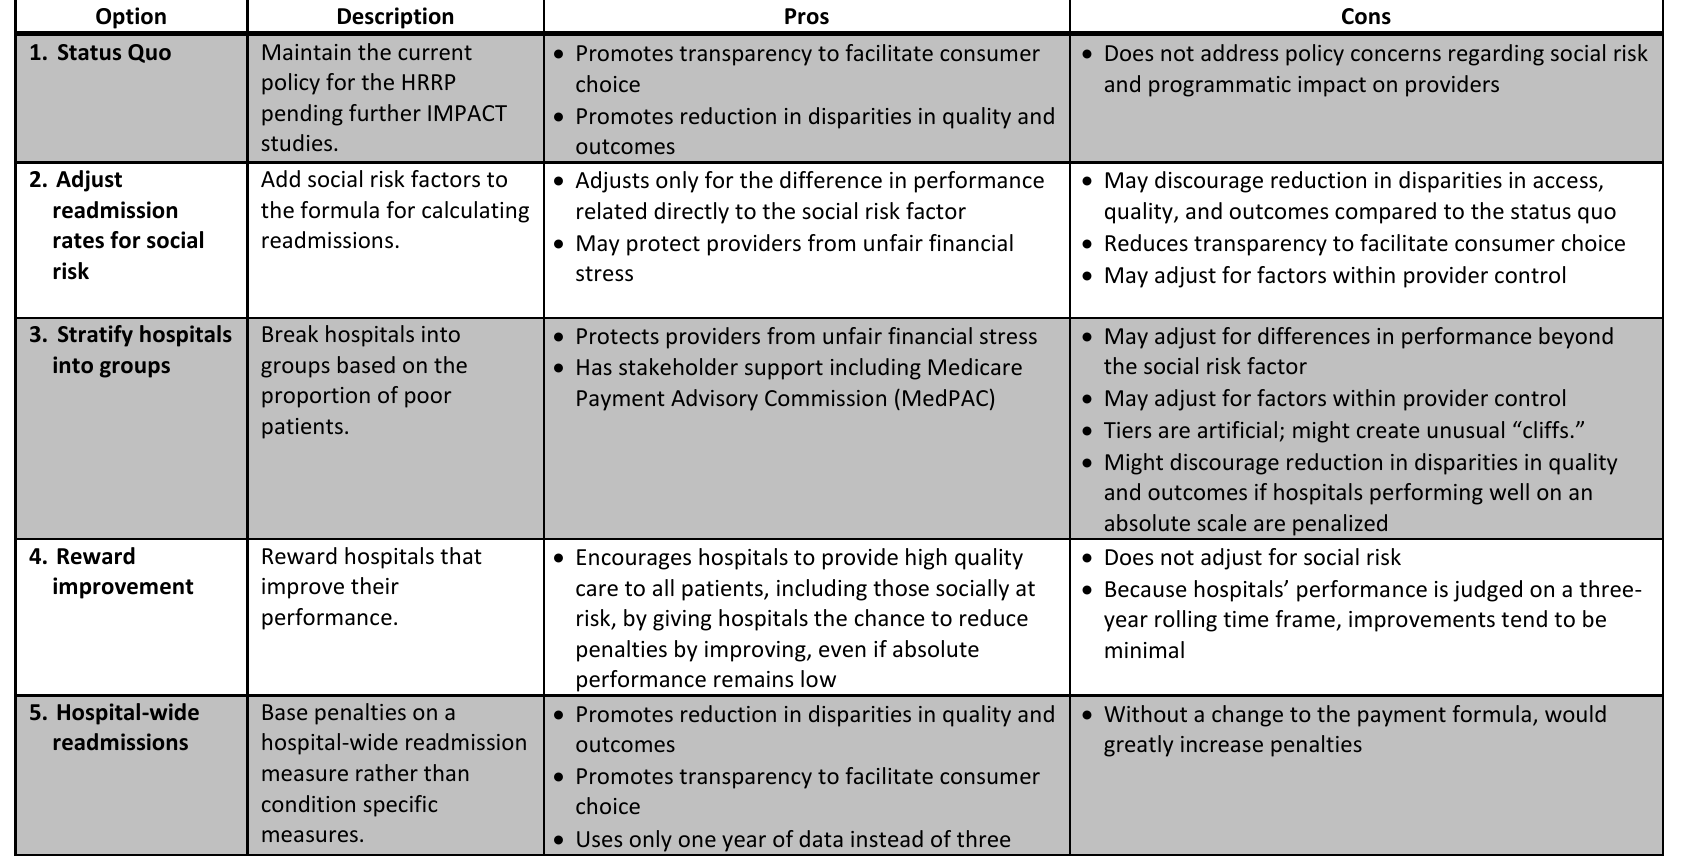
Table 5.7. Summary of the HRRP Policy